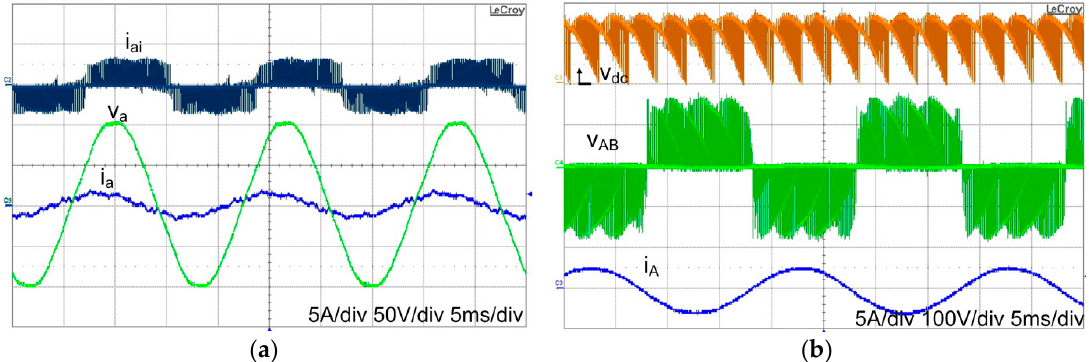
Figure 16. ( a ) Input waveforms; and ( b ) DC-link voltage and output waveforms with the proposed method at m = 0.35 and f out = 50 Hz ( PF = 0.91).